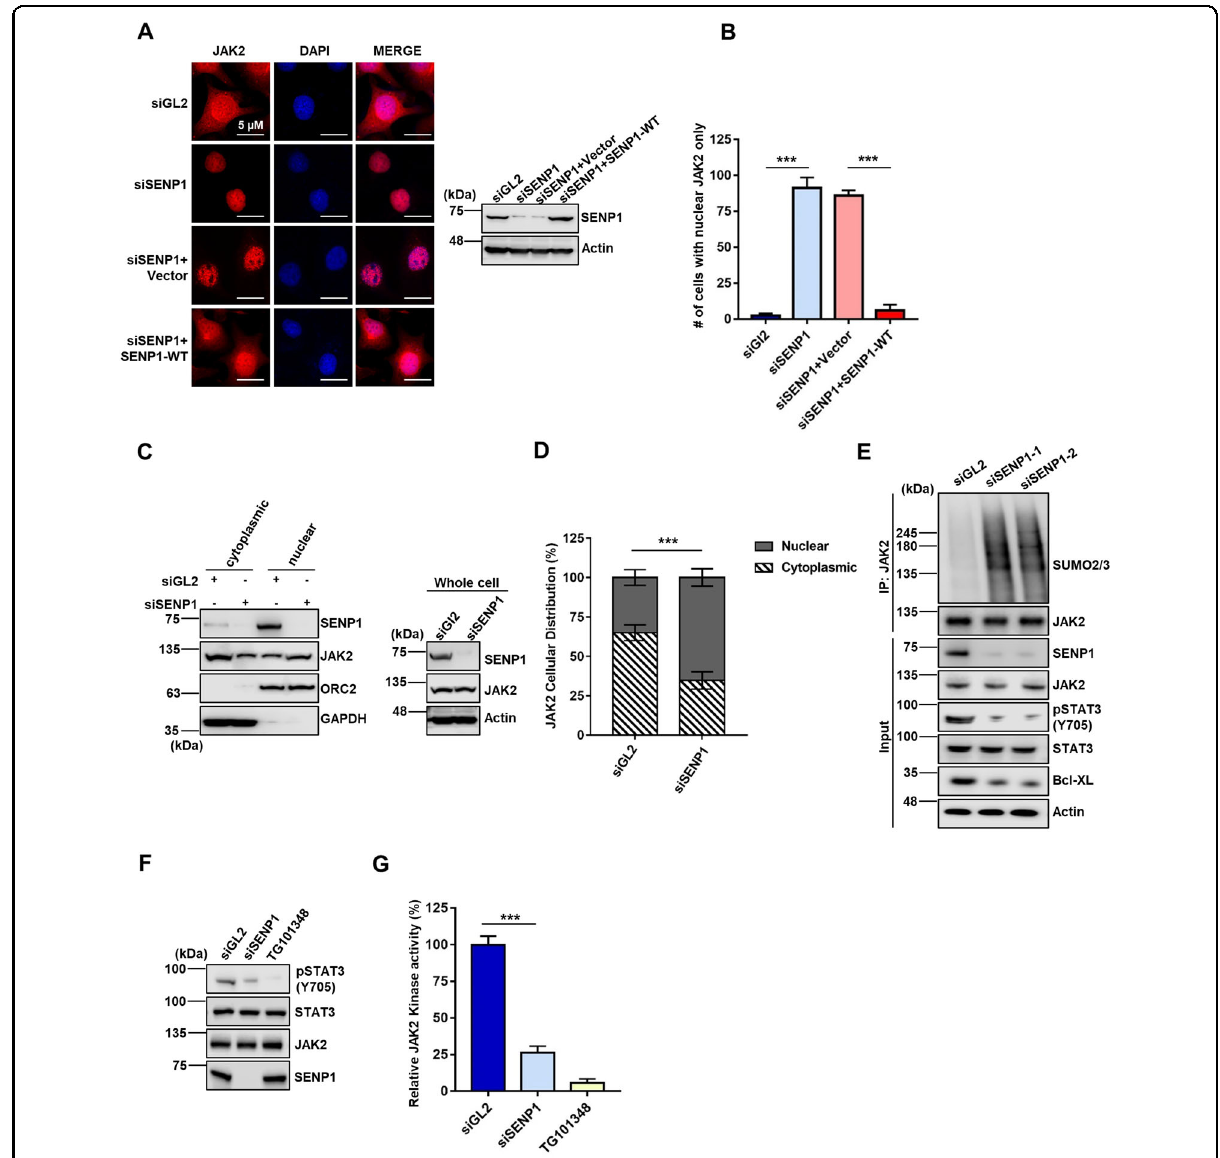
JAK2 antibody. Scale bar: 5 µm. Right panel, SENP1 expression in treated cells. B Quanti fi cation of JAK2 cellular distribution in IGROV1 cells as shown in ( A ). In total, 100 cells were counted in each sample. ***, p < 0.001. C Nuclear fractionation of JAK2 in IGROV1 cells treated with siGL2 or siSENP1, followed by Western blot for indicated proteins. D Quanti fi cation of JAK2 fractionations shown in ( C ). ***, p < 0.001. E SENP1 knockdown decreases expression of pSTAT3 (Tyr705) and Bcl-Xl. IGROV1 cells treated with indicated siRNAs, followed by Western blot with indicated proteins. F SENP1 knockdown decreases pSTAT3 (Tyr705) by JAK2 in vitro. Recombinant STAT3 was incubated with puri fi ed JAK2 from IGROV1 cells treated with siRNAs or JAK2 inhibitor (TG101348) for in vitro kinase assay as described in “ Materials and Methods ” . Cells lysates were resolved in SDS-PAGE gel, followed by Western blot for indicated proteins. G Quanti fi cation of pSTAT3 (Tyr705) levels in three independent experiments. ***, p <